Question: State the chart type depicted above.
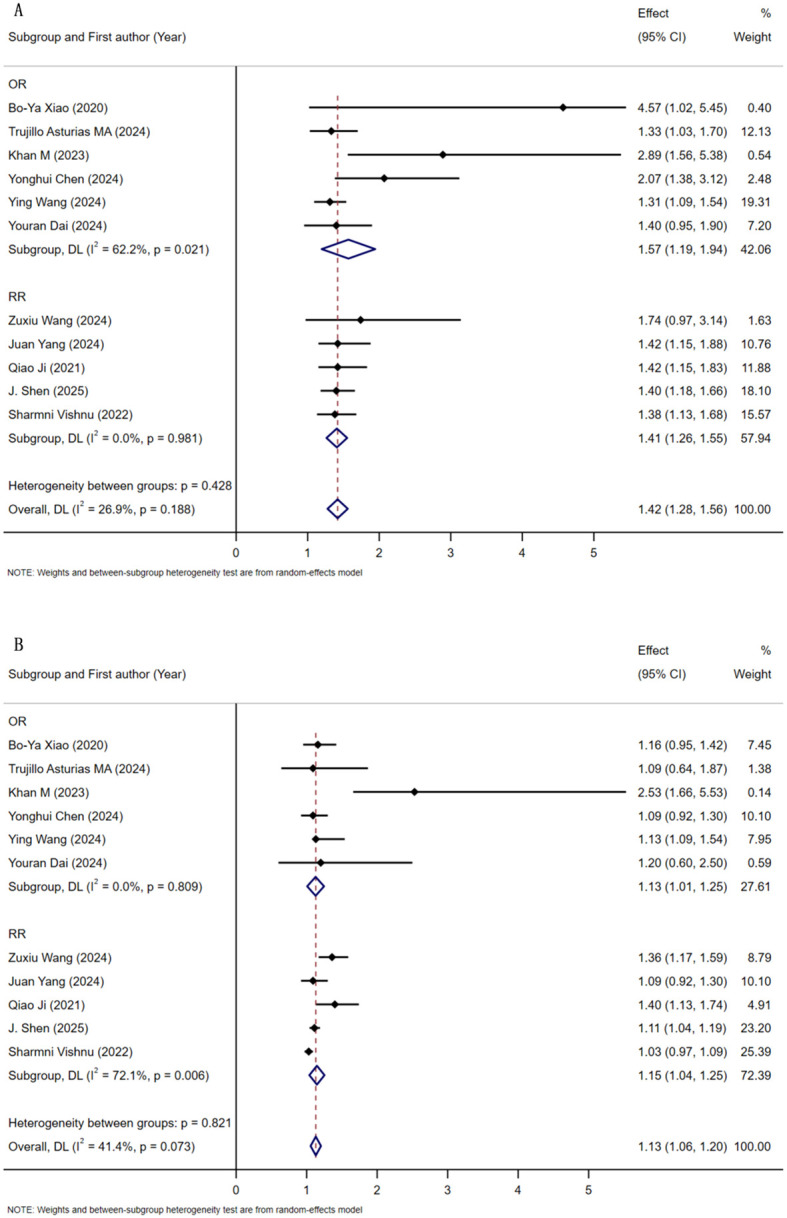
Answer: forest